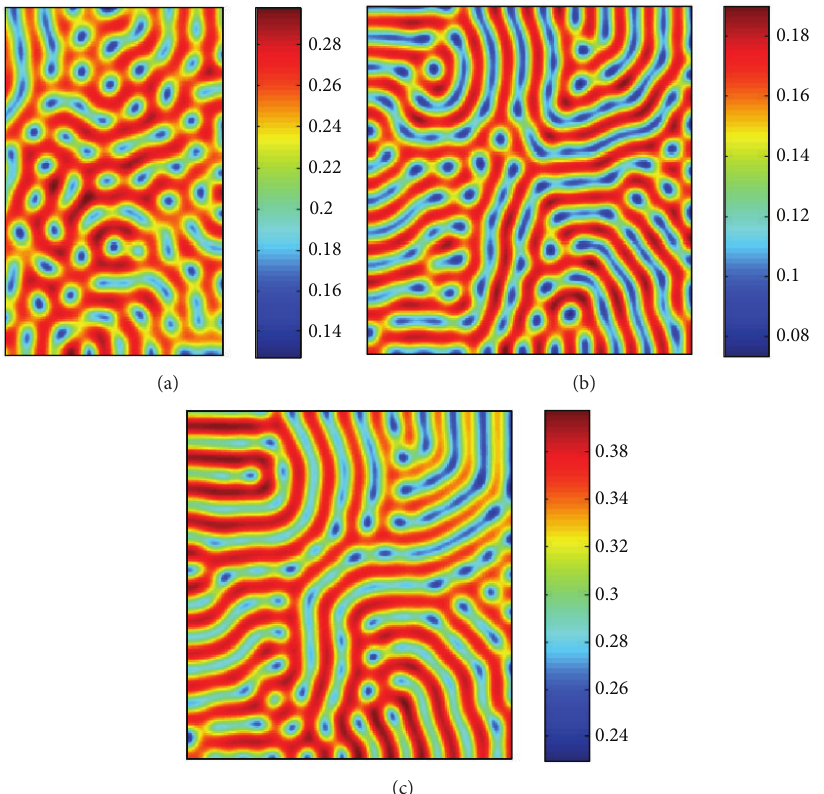
Figure 6: Snapshots of contour pictures of the time evolution of predator in system (3) when 𝑑 2 = 7 and 𝛿 𝑤 < 𝛿 = 0.34 < 𝛿 𝐻 : (a) 50000 iterations, (b) 100000 iterations, and (c) 200000 iterations.